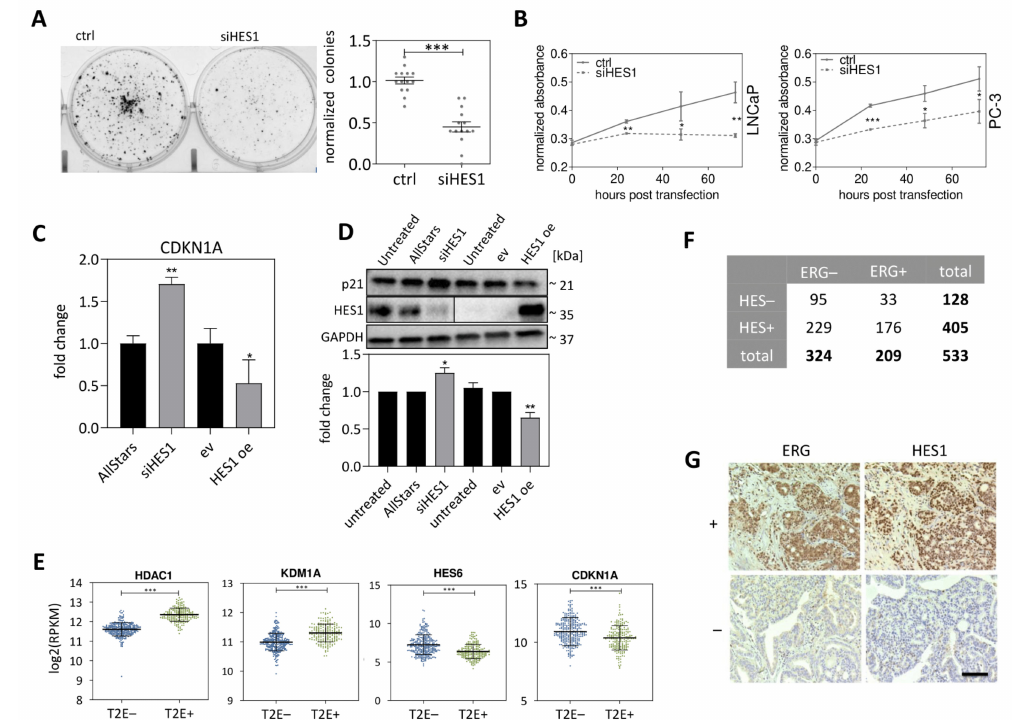
Figure 7. Consequences of HES1 knockdown and overexpression in T2E+ PCa. ( A , B ) Colony formation and proliferation assays upon HES1 knockdown. Representative images of ( A ) LNCaP colony formation assays and ( B ) LNCaP and PC-3 WST-1 assays in scrambled siRNA (ctrl), and HES1 siRNA (siHES1) treated conditions. ( C ) CDKN1A mRNA expression upon siRNA-mediated HES1 knockdown and transient HES1 overexpression (HES1oe). ( D ) Western blot of HES1 and p21 after HES1 expression perturbation (Blot is derived from two different, parallel processed membranes due to HES1- GAPDH signal interference). ( E ) HDAC1 , KDM1A , HES6 and CDKN1A expression in PCa tissue specimens from the TCGA-PRAD data cohort (* p ≤ 0.05; ** p ≤ 0.01; *** p ≤ 0.001). ( F ) Contingency table of ERG/HES1 tissue microarray data. ( G ) Representative images of positive and negative staining of PCa tissue microarray for ERG and HES1, respectively (scale bar indicates 150 µ